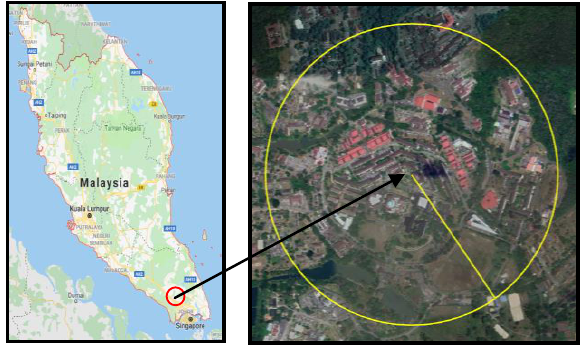
Figure 1. Location of Lingkaran Ilmu, UTM (Source: Google Earth)